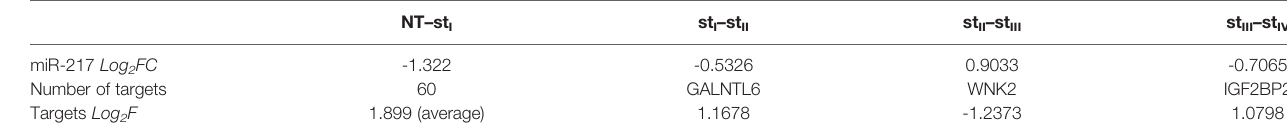
TABLE 5 | Expression statistics for miR-217 and its target